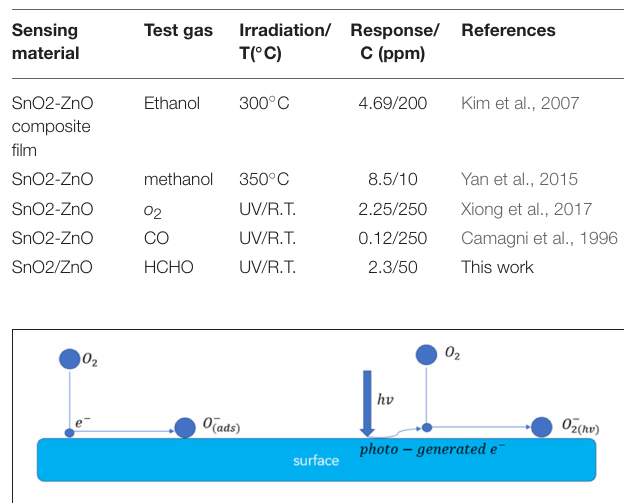
FIGURE 9 | Schematic illustration of possible enhanced gas sensing mechanism of the sensors under 365nm light activation.